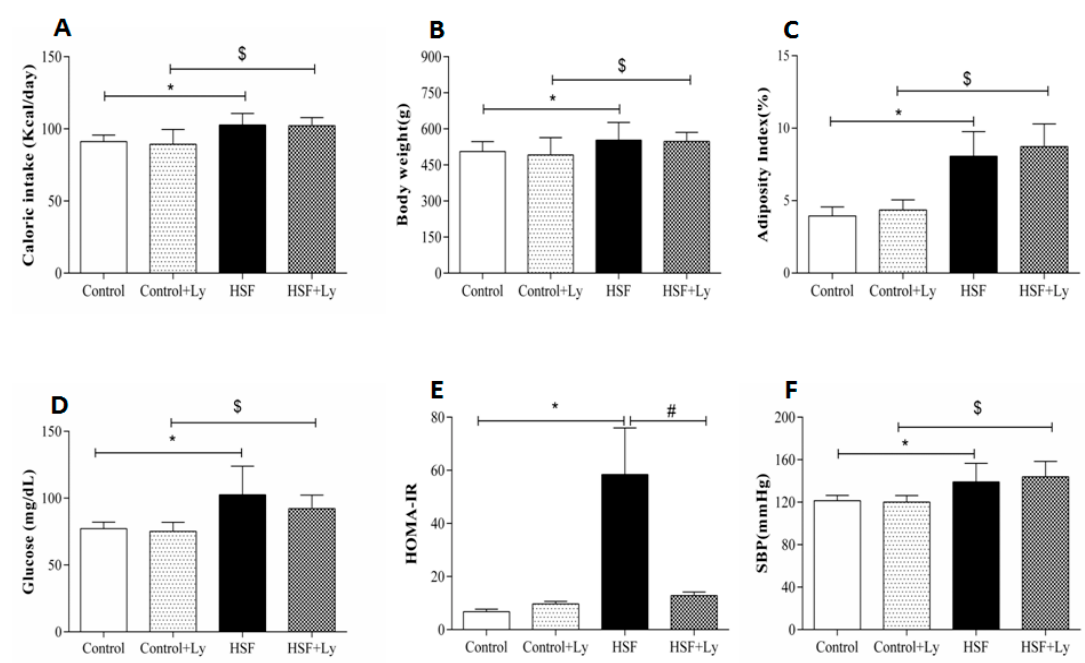
Figure 1. Nutritional and cardio- metabolic parameters. A —caloric intake (kcal / day); B —adiposity index (%); C —final body weight (g); D —glucose (mg / dL); E —HOMA-IR; F —systolic blood pressure